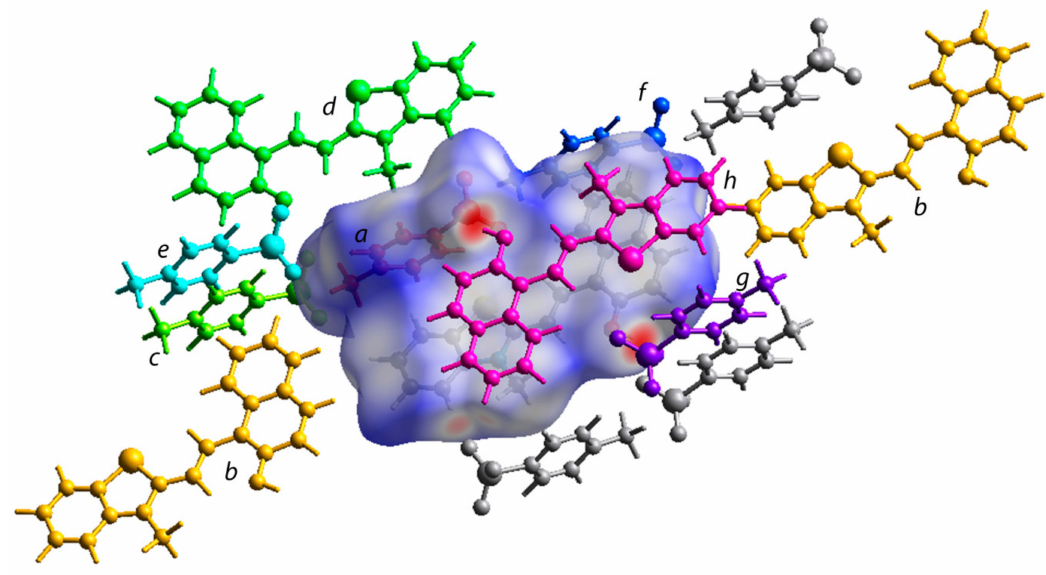
Figure 6. The Hirshfeld surface incorporating the asymmetric unit showing the interactions with the neighboring molecular units in the crystal packing. Di ff erent molecular units around the central molecule are labelled from a-h. Table 2. The energies of interaction (kJ / mol) between the molecular pair calculated using the Crystal Explorer (TONTO) program using the B3LYP / 6-31G(d,p) method. Frag.